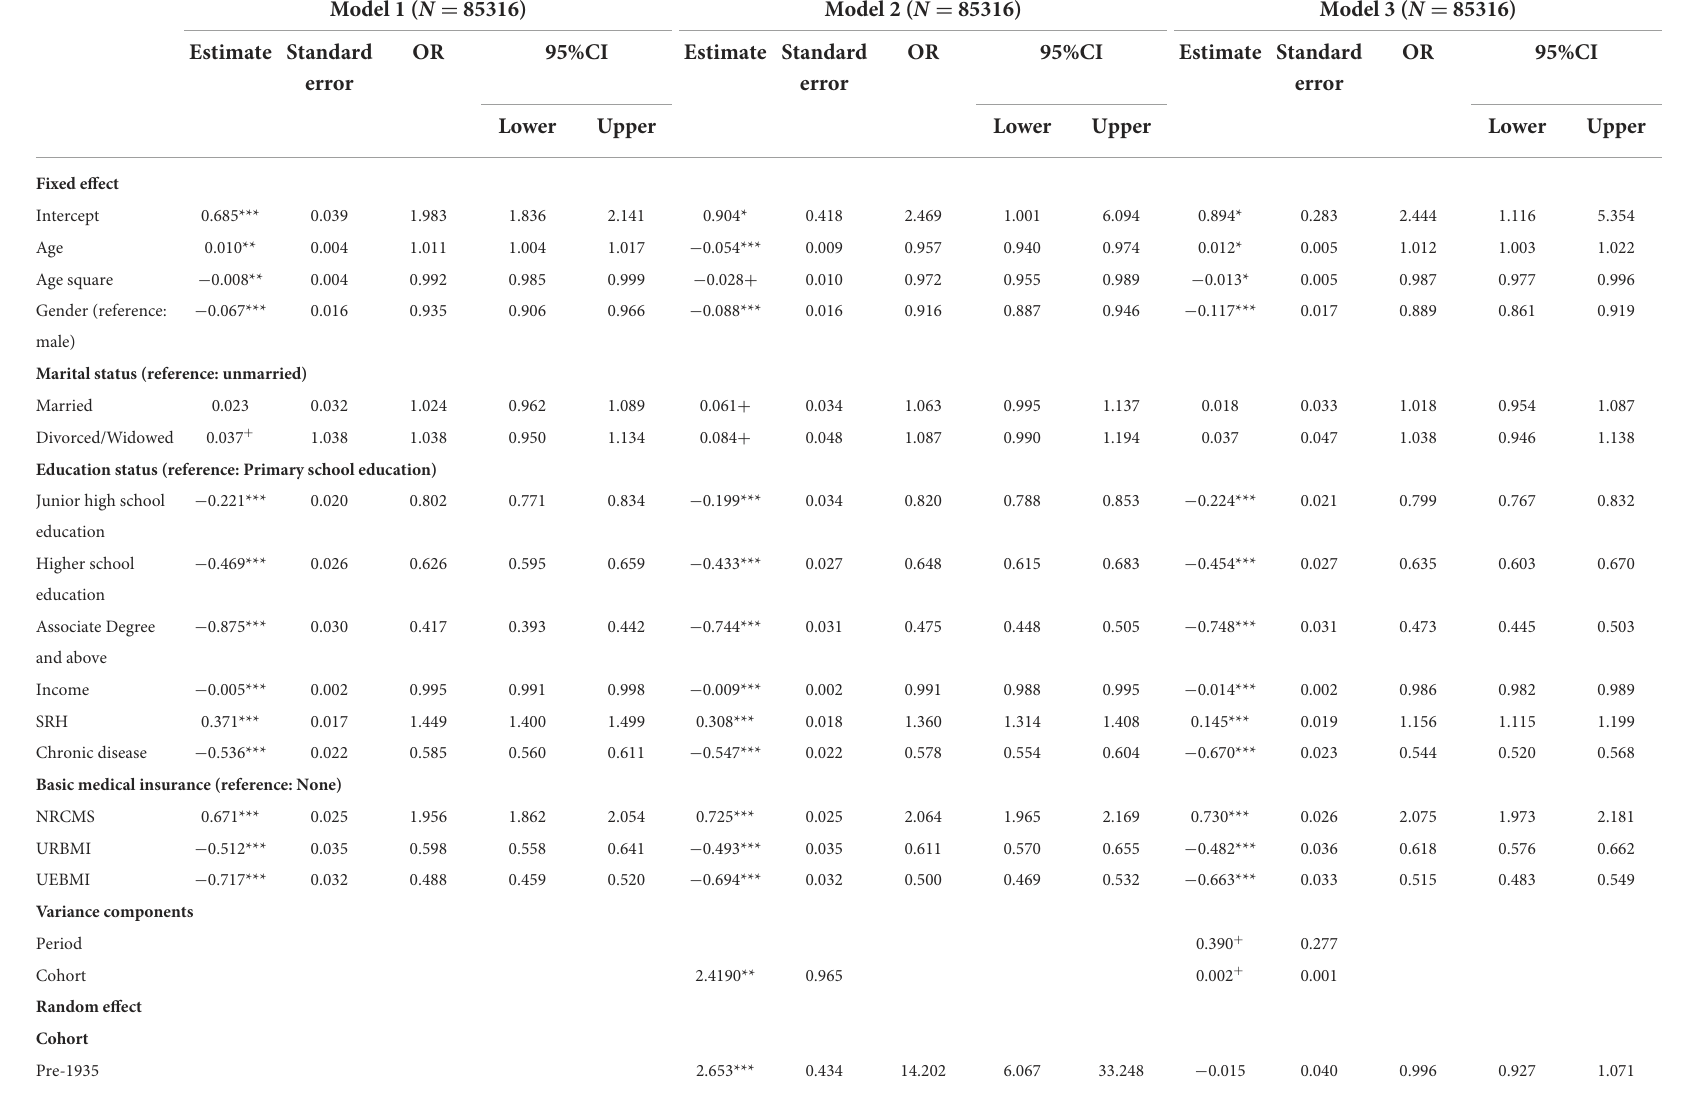
TABLE 1 The effect of basic medical insurance participation, age, period, and cohort on behavior of seeking primary